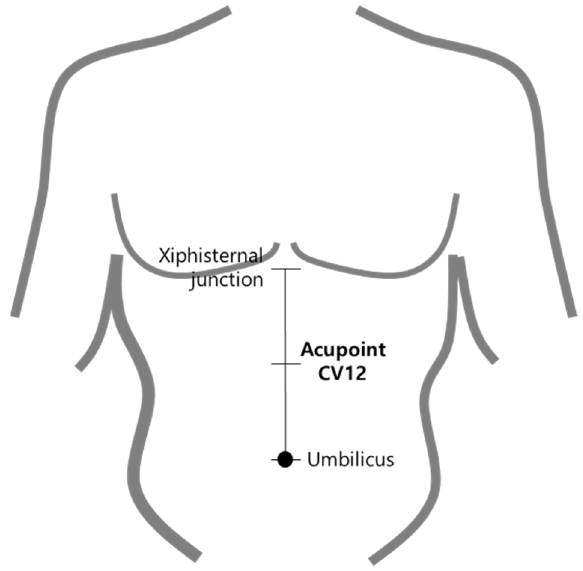
Figure 1. Location of Acupoint CV12.